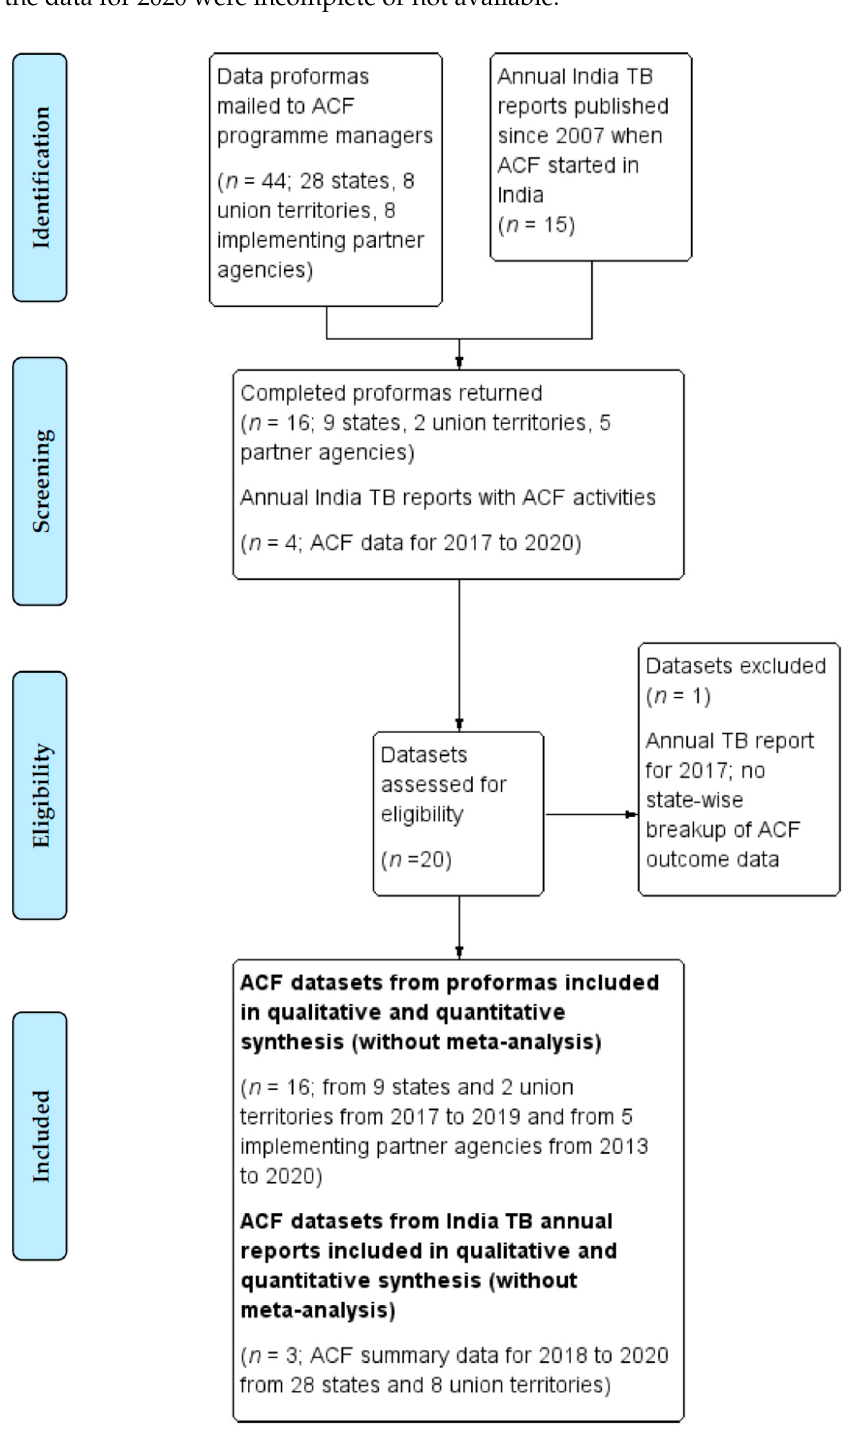
Figure 2. Flow diagram, in accordance with the PRISMA (Preferred Reporting Items for Systematic Reviews and Meta-Analysis) statement, for the identification and selection of data on community- based active case finding (ACF) activities supported by the National Tuberculosis Elimination Programme (NTEP) of India.